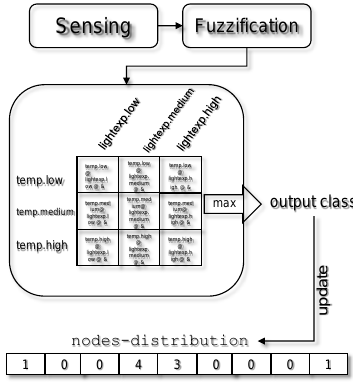
Figure 8. The word “thermal-zones” operates by sensing the temperature and light. Both sensory readings are treated as crisp input and fuzzified according to the membership functions of lightexp and temp . The rule generation considers all the pairs of truth values related to linguistic variables bound to different fuzzy variables. This is justified by the fact that each combination represents a different thermal zone identified by distinct temperature and light conditions. Indeed, the index of the cell storing the maximum value represents the thermal zone the node belongs to. The cell correspondent to the output class is incremented in nodes-distribution in order to allow each node to assess the distribution of the